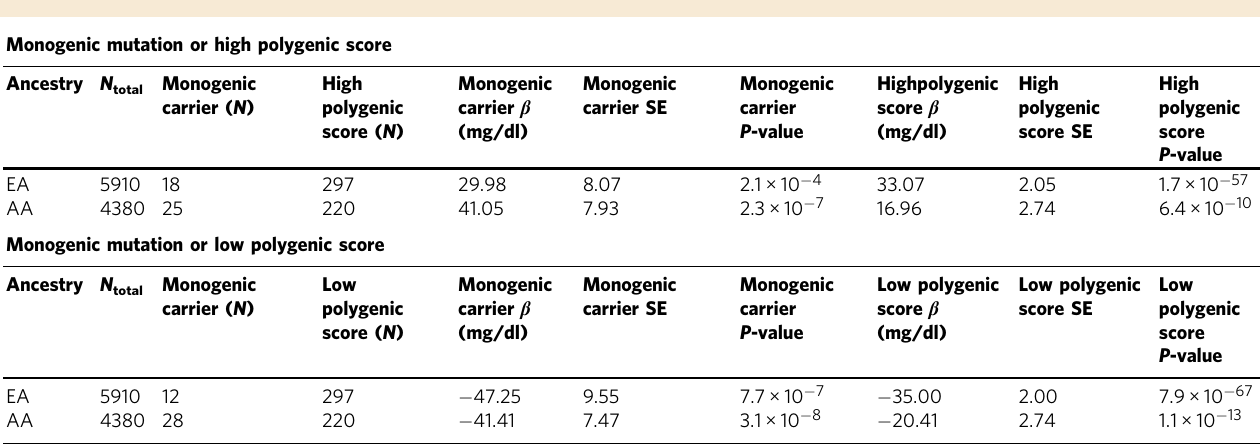
Values are represented asbeta [95% CI] in mg/dl for LDL-C. Multi-variableassociations were performed with sex + age + age 2 (effects not listed) with monogenic carrier status + high polygenic score using linear regression. Polygenic risk score was derived from 2 million variants using LDpred. High polygenic score was de fi ned as membership in the top 5th percentile of the ancestry-speci fi c score distribution. AA, African American; EA, European American; SE, standard